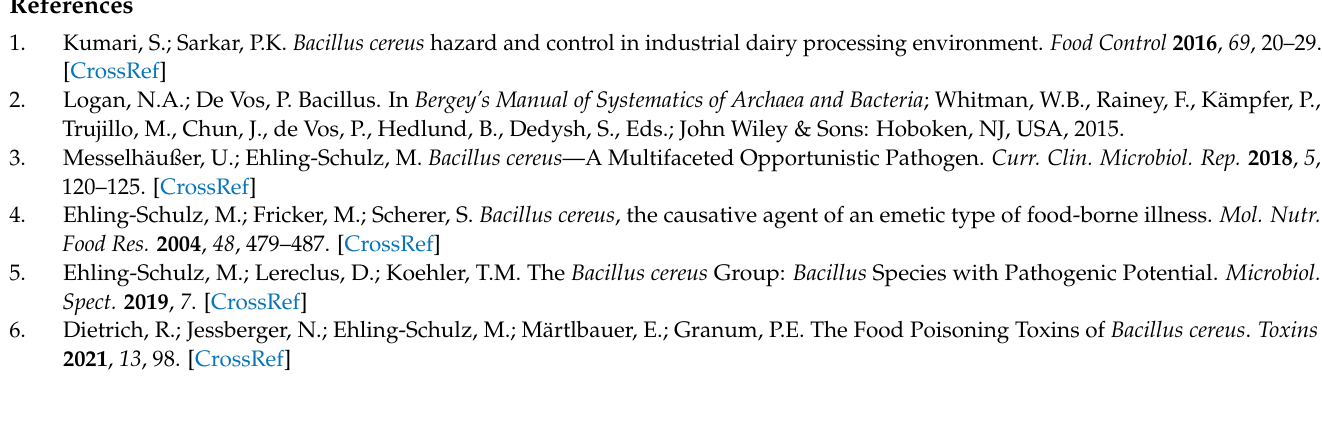
Table S4B: Background information on naturally contaminated milk samples; Table S5: Accordance in the detection of Bacillus cereus group in naturally contaminated samples ( n = 64) before and after freezing on selective agar media; Table S6: panC group and toxin gene profile combinations of Bacillus cereus group detected before and after freezing ( n = 64